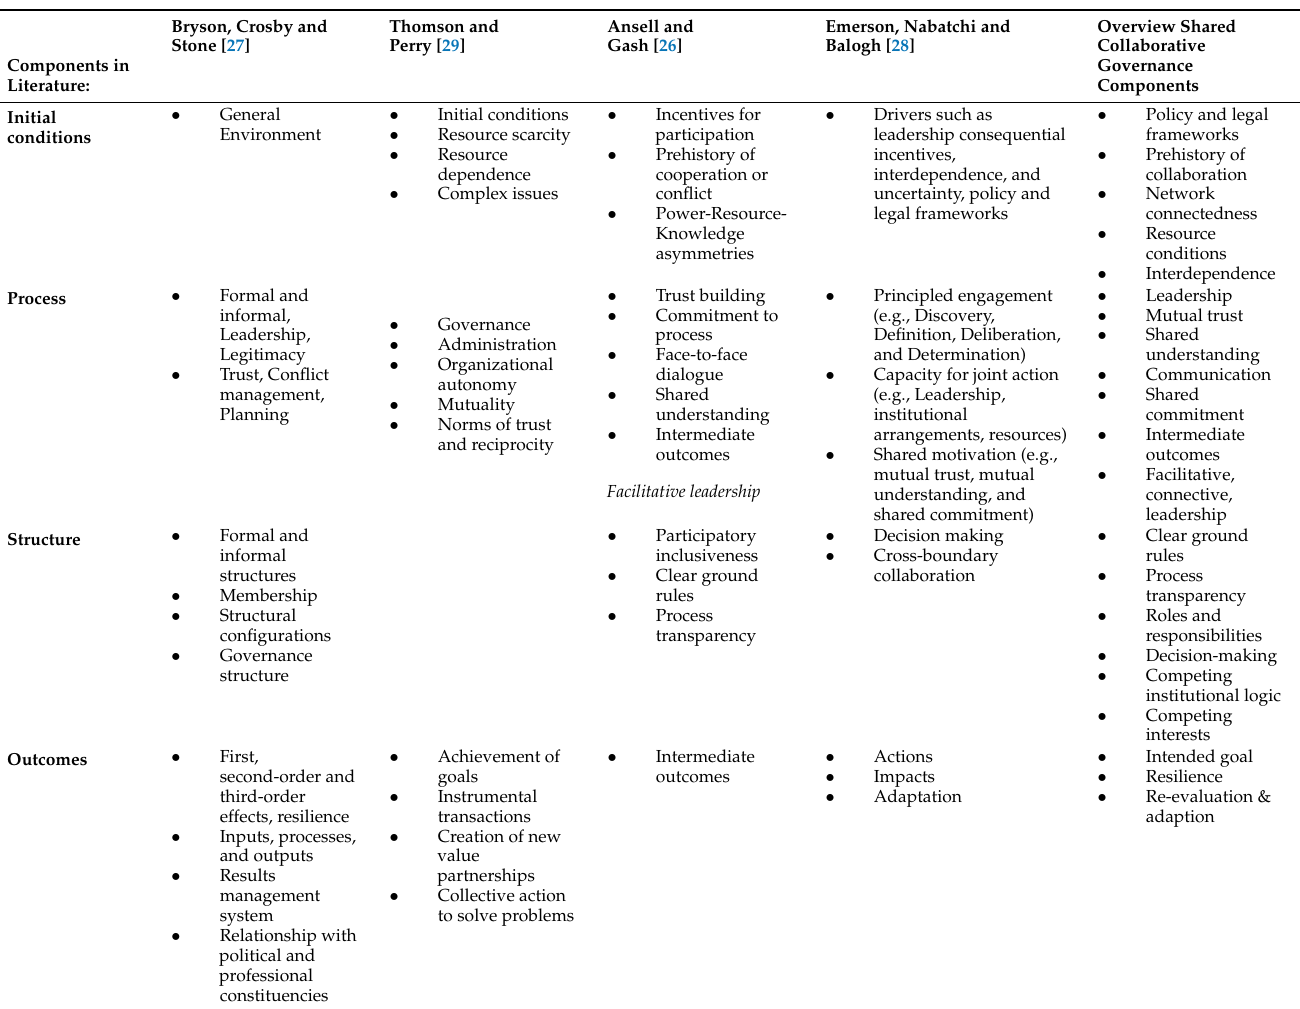
Table 2. Components of smart governance based on collaborative governance